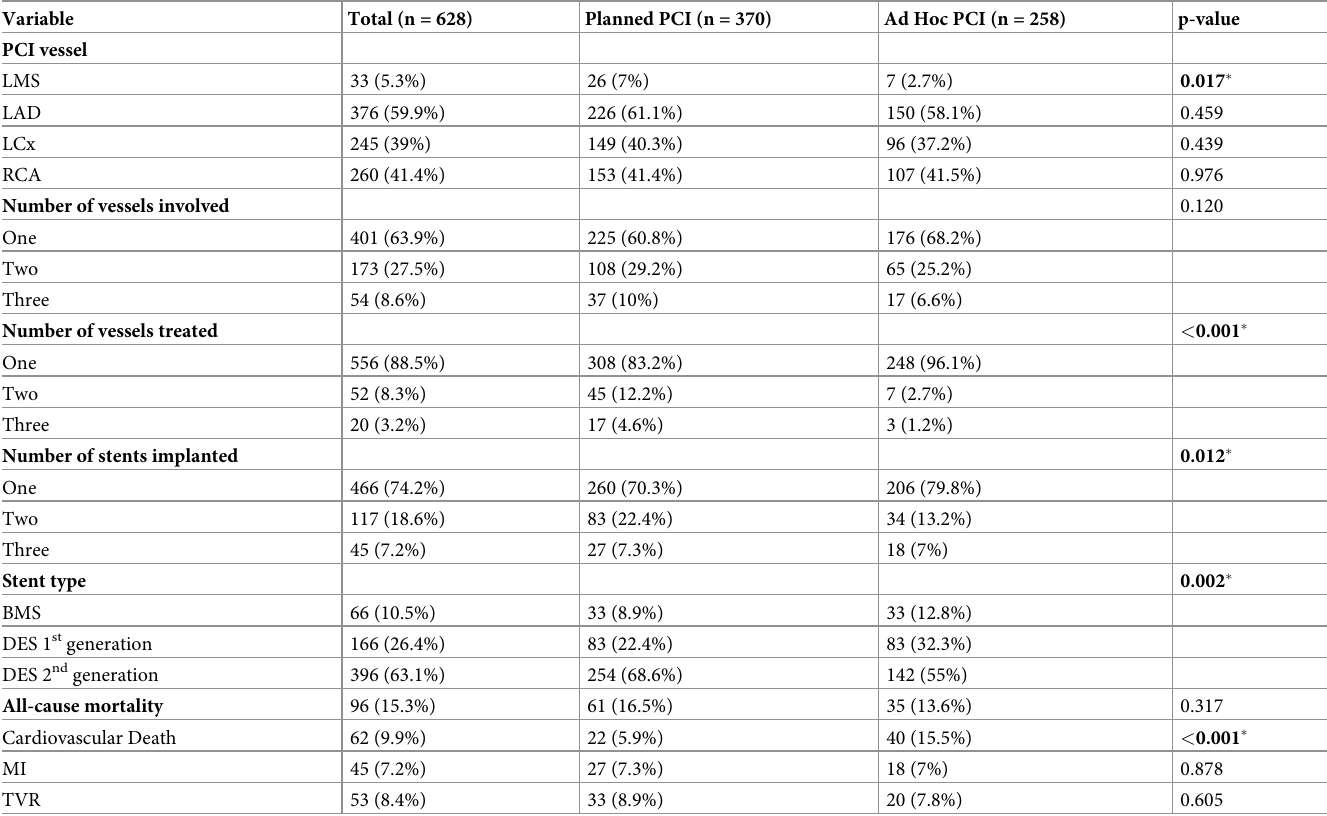
Table 2. Procedural characteristics and MACE.